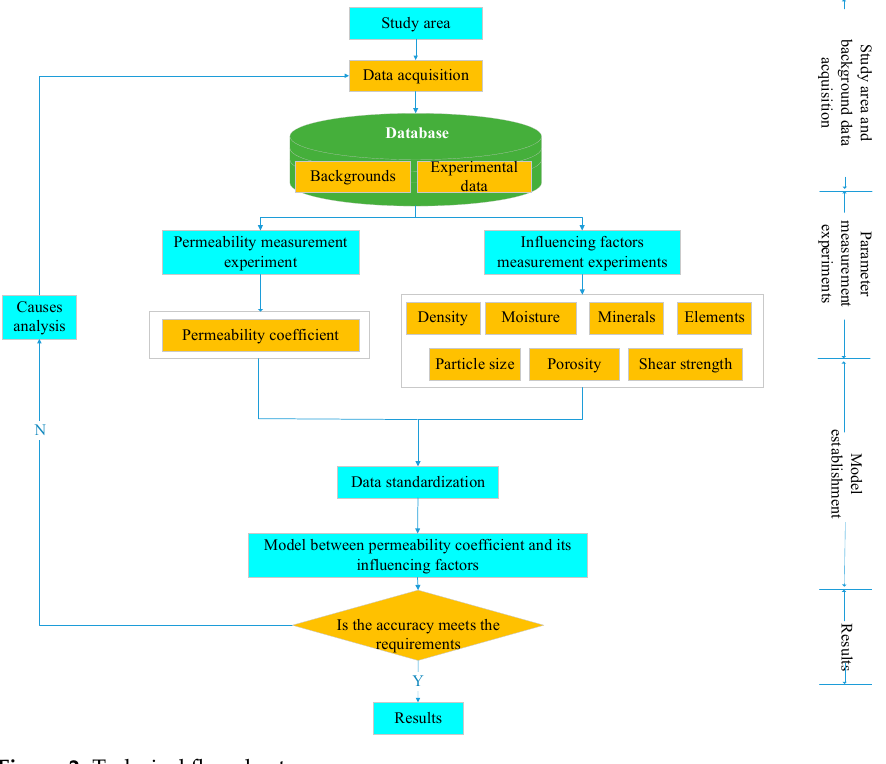
Figure 2. Technical